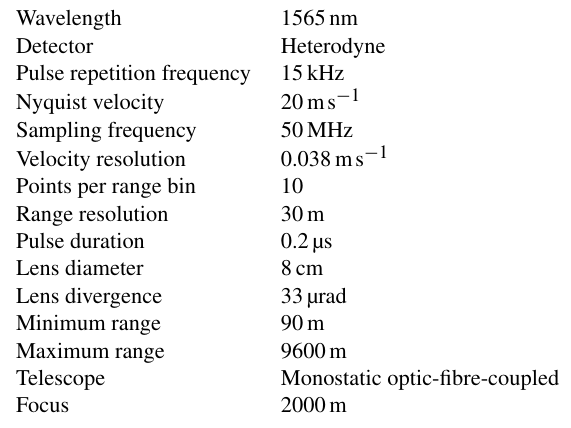
Table A1. Summary of the technical specifications of the Halo Streamline Doppler